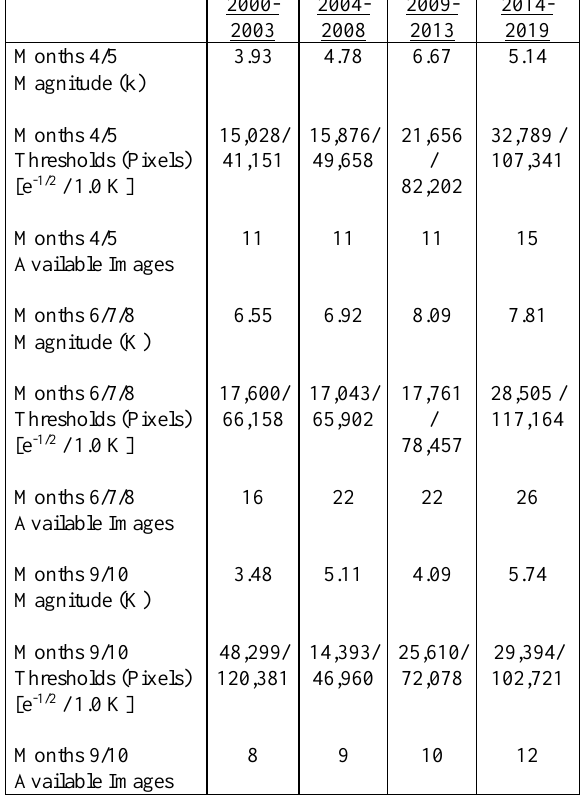
Table 2 . The results from the time frames analysis